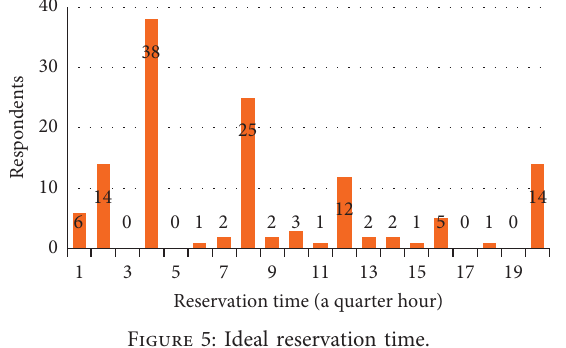
Figure 5: Ideal reservation time.